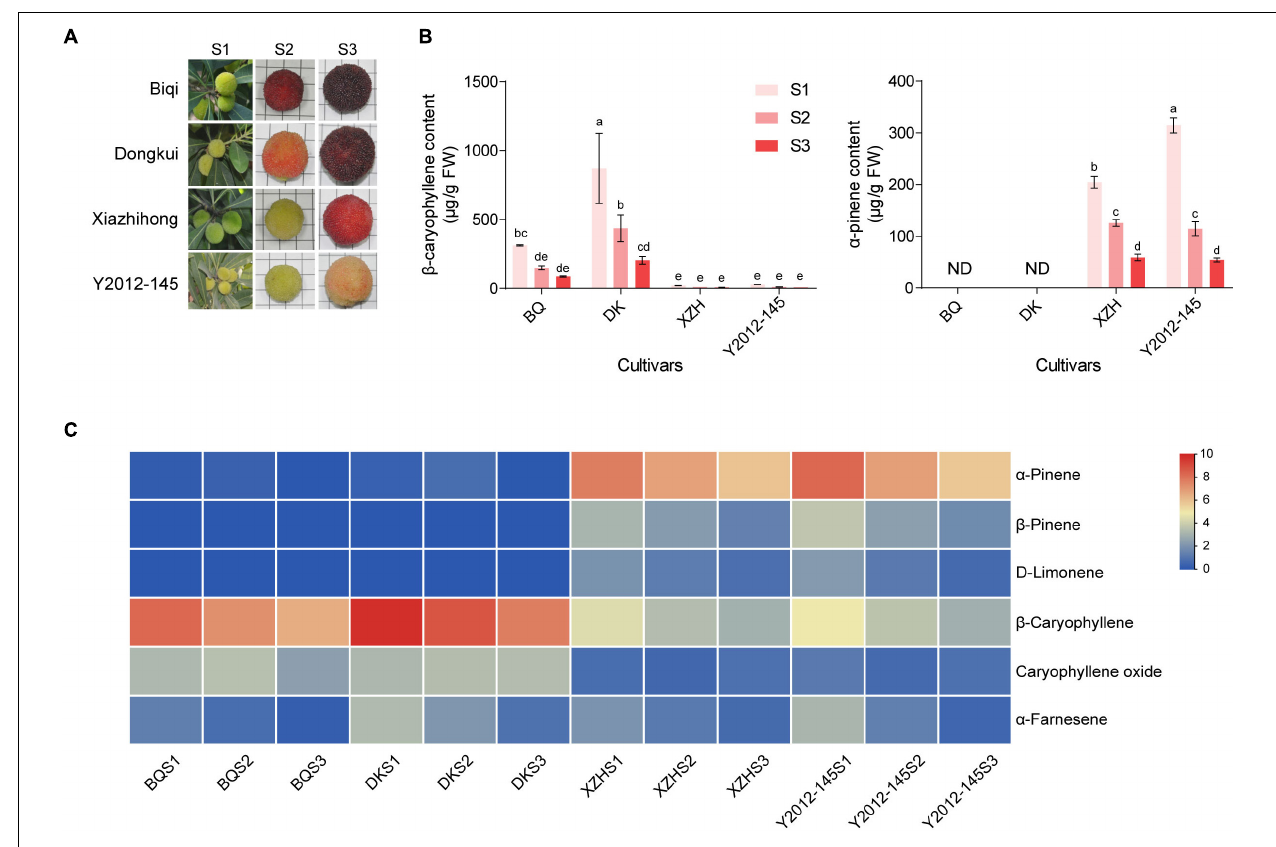
FIGURE 1 | Fruit appearance and VOC contents in four cultivars of red bayberry. (A) Photos of red bayberry fruits at three stages in four cultivars. S1, S2, S3 show the three fruit developmental stages. (B) Main VOCs in red bayberry. “ND” indicates not detectable. “BQ,” “DK,” and “XZH” indicate ‘Biqi,’ ‘Dongkui,’ and ‘Xiazhihong’ cultivars, respectively. Error bars indicate standard deviation of three biological replicates. Different letters indicate significant difference among stages and cultivars (one-way ANOVA, p < 0.05). (C) Heatmap of VOC contents at three development stages in the four cultivars. Normalized contents are showed in blue (low) to red